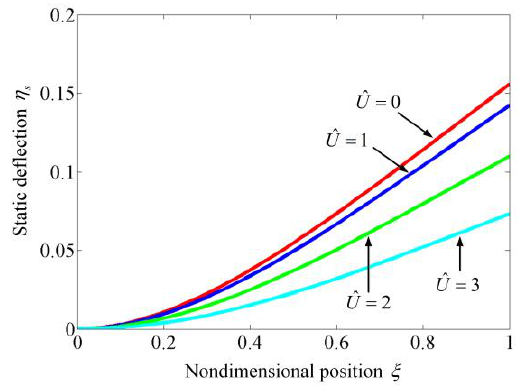
2 = 1  and various ˆ U . ˆ U .